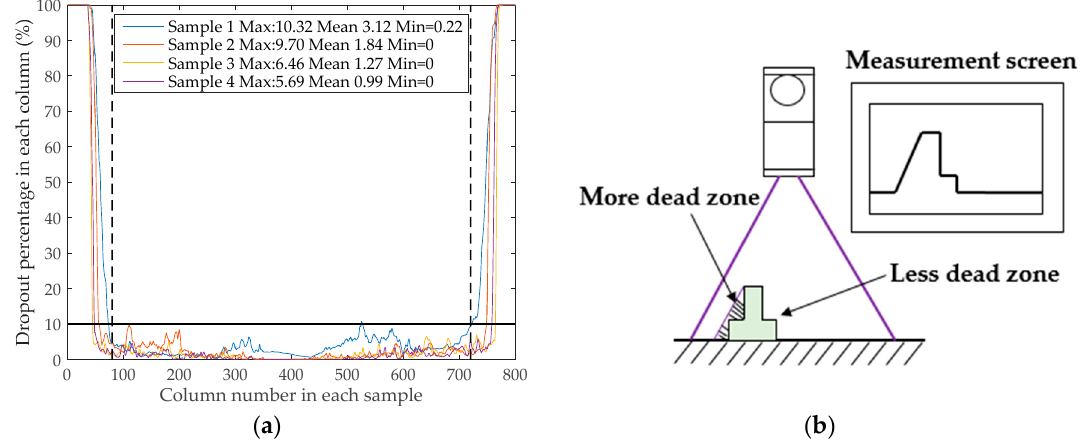
Figure 4. ( a ) Distribution of the dropout percentage in different areas for each sample; ( b ) the formation of the dead zone during scanning [26].